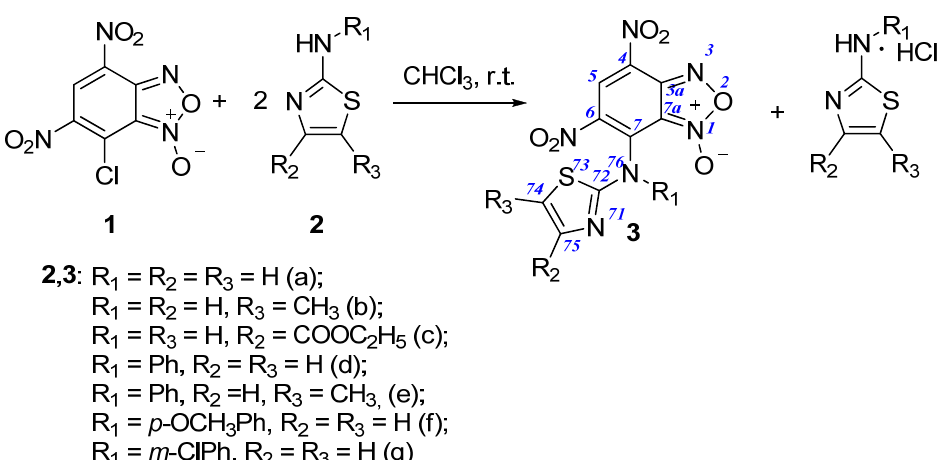
Figure 3. The structure of the salt formed as a